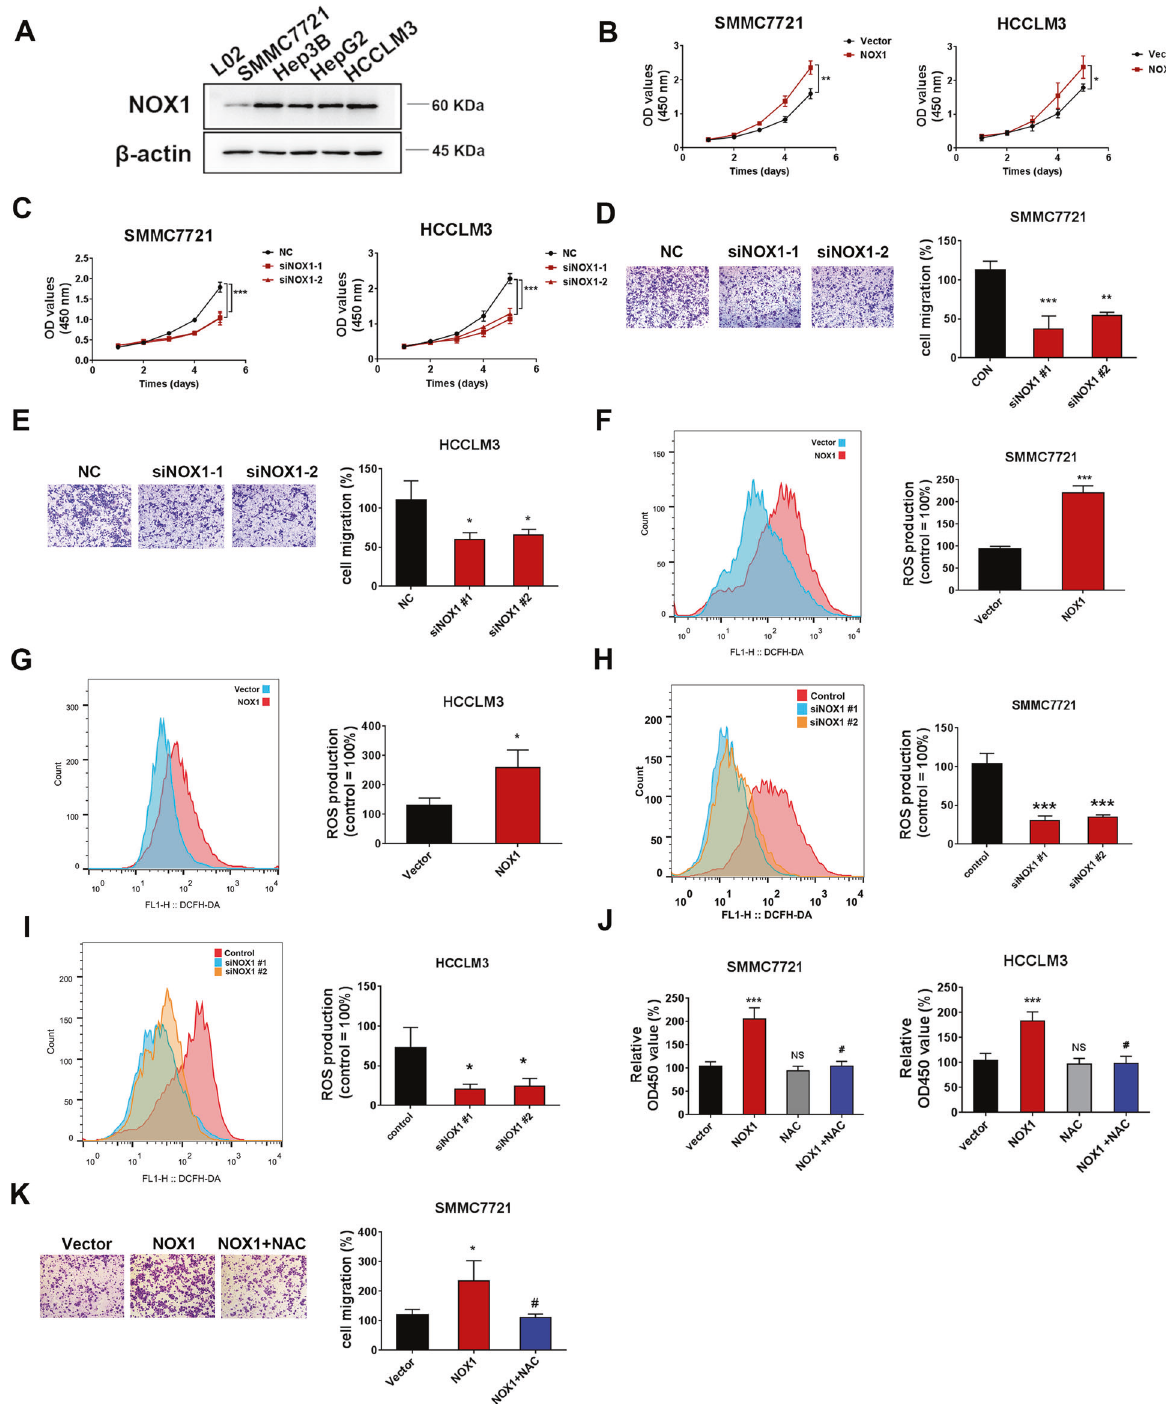
Fig. 5 NOX1-induced ROS activity promotes the proliferation and migration of HCC cells. Western blot analysis of NOX1 expression in 4 HCC cancer cell lines ( A ). SMMC7721 and HCCLM3 cells were transfected with siNOX1 or the negative control, as well as NOX1 overexpression plasmid or vector control. B , C growth curve and D , E transwell assays were performed to detect the proliferation and migration of SMMC7721 and HCCLM3 cells. DCFH-DA fl uorescence was used to evaluate the total ROS production in two cell lines mentioned above ( F – I ). The levels of cell viability and migration were analyzed in NOX1 overexpressed HCC cells and NOX1 overexpressed HCC cells with NAC (5 mM) pretreatment for 2 h ( J , K ). Original magni fi cation, ×100 (scale bars: 100 μ m). Data indicated mean ± SD. n = 3, * P < 0.05, ** P < 0.01, *** P < 0.001, # Compared with NOX1